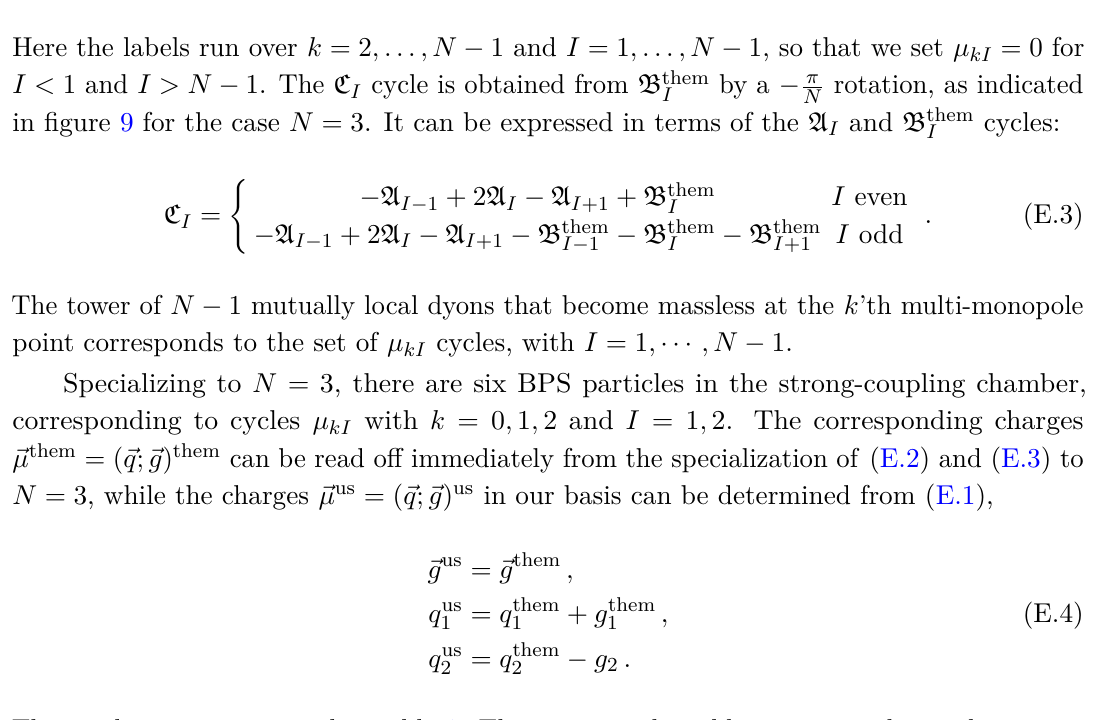
Figure 9. The left panel shows the conventions for the ˆ A I , B I , and C I cycles that are used in [35]. The right panel shows our conventions for the ˆ A I , B I cycles. In this figure we have specialized to N = 3 , with ε = e 2 πi 6